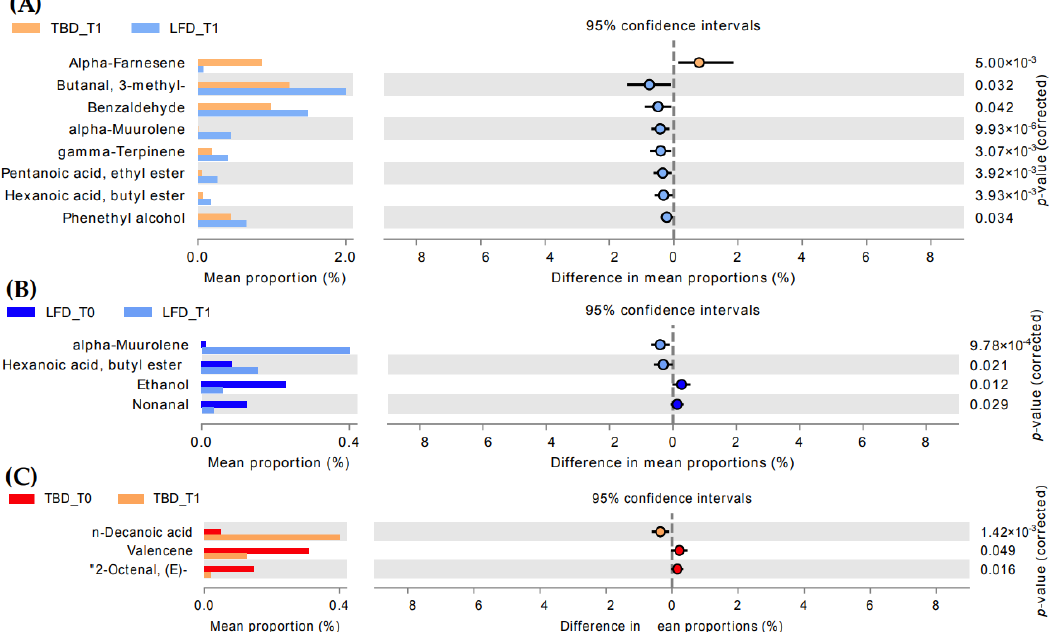
Figure 3. Extended error bar-plot of statistically significant volatile organic compound differences (Wilcoxon rank-sum’s test) resulted from pairwise comparison between TBD and LFD groups after treatment ( A ) and within each group: ( B ) = LFD and ( C ) = TBD. Abbreviations: LFD, low-FODMAPs diet; TBD, tritordeum-based diet.